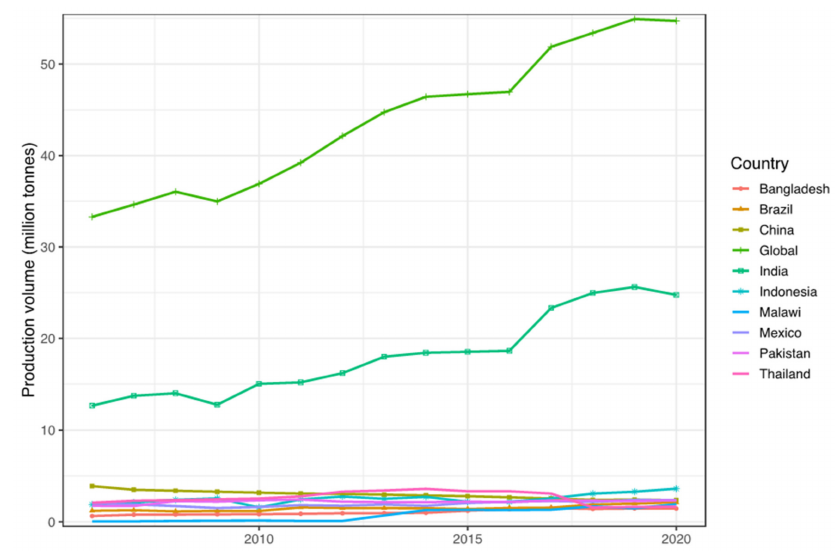
Figure 2. The top 10 producers of fresh mangosteen in the world. Data [11]. The mangosteen tree has dark brown or nearly black flaking bark, and the tree’s inner bark contains yellow, gummy, and bitter latex [12]. At the same time, the leaves are short-stalked, ovate-oblong, or elliptic, leathery, thick, dark green, slightly glossy above, yellowish-green, and dull beneath. The leaf size is around 9 to 25 cm long and 4.5 to 10 cm wide, with a conspicuous, pale midrib [13]. Flowers are 4–5 cm wide, fleshy, male, or hermaphrodite on the same tree, with four sepals and four ovate. The fruit is rounded, dark purple to red–purple, and smooth externally, 3.4–7.5 cm in diameter and weighs 70–150 g; the rind is 6–10 mm thick, with four to eight triangular segments of snow-white, juicy, soft flesh [14]. Mangosteen trees require an average annual rainfall of around 1270 mm, the ideal temperature for mangosteen growth is between 25 and 35 ◦ C, with more than 80% relative humidity, and this tree can grow well in coarse soils, slit and is able to be well-drained. Mangosteen can be cultivated in a wide range of altitudes, between 76 and 500 m above sea level